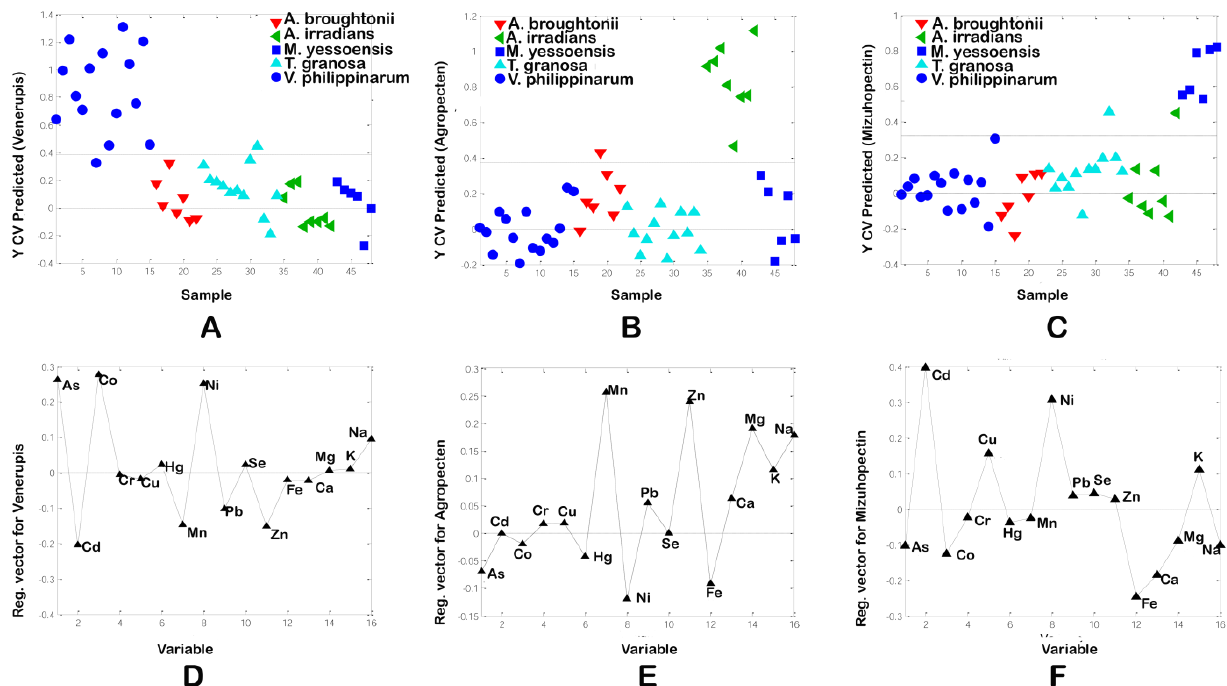
Figure 3. PLS-DA based on element content: scores plots of data and plot of the coefficients of parameters in model for V.phillipinarum ( A , D ), A. irradians ( B , E ), and M. yessoensis ( C , F ), respectively.